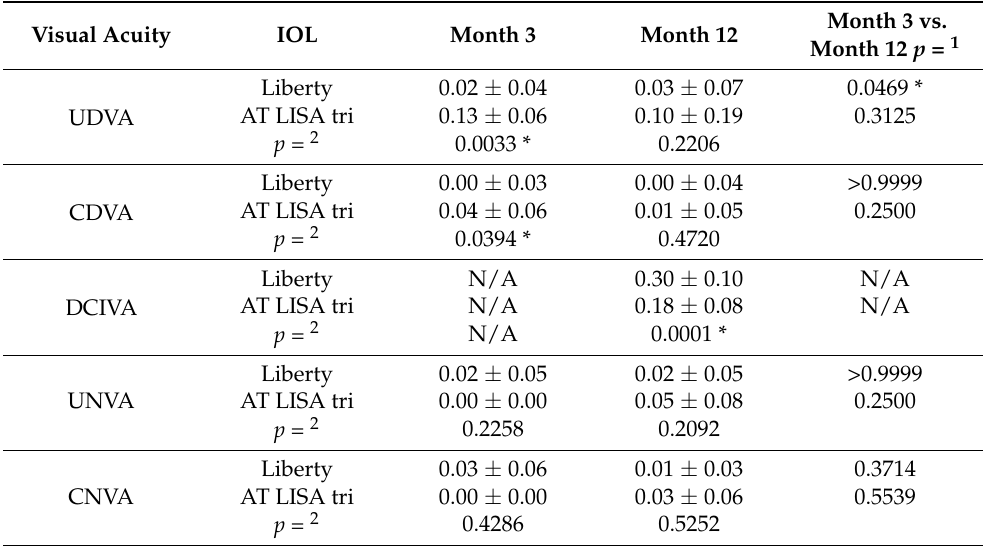
Table 2. Monocular distance (logMAR) and near (Jaeger) visual acuities, measured 3 and 12 months postoperatively. Data are presented as mean ± SD.